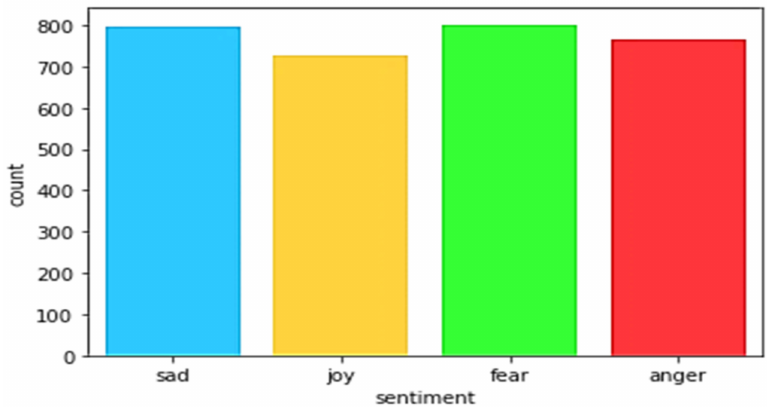
Figure 1. Tweets’ sentiment